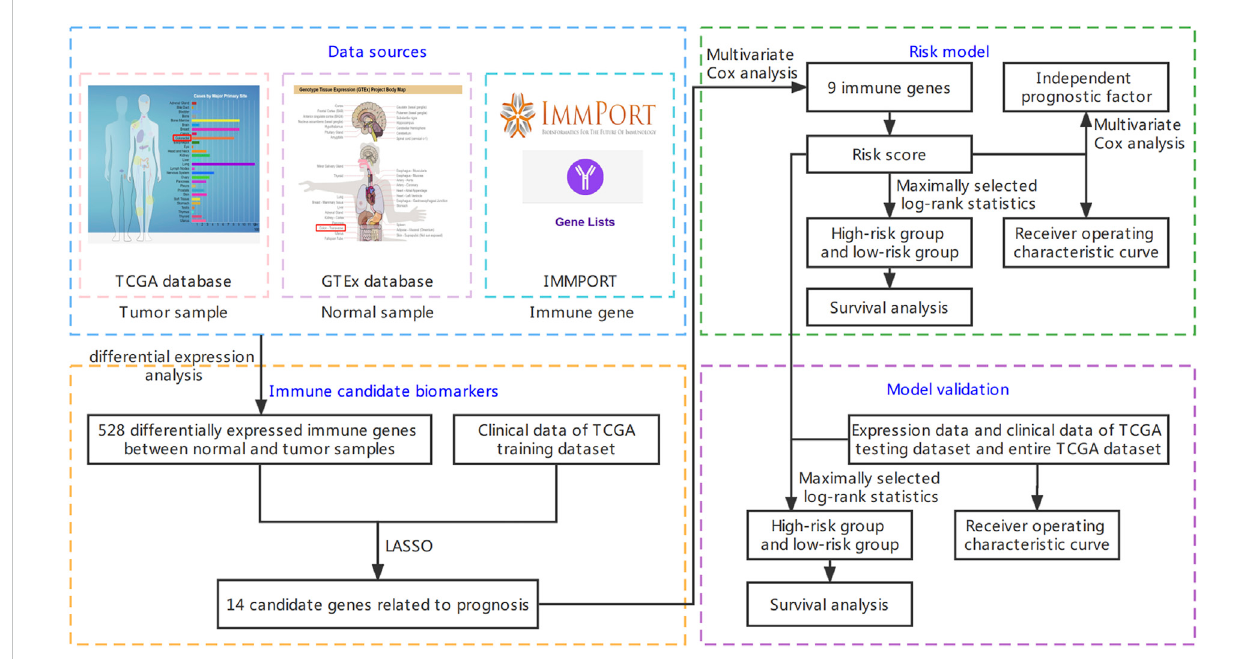
FIGURE 1 Flow chart of this study. It is mainly divided into four parts: downloading data, screening immune candidate biomarkers, building risk model, and model validation. The detailed steps are shown in the fi gure.